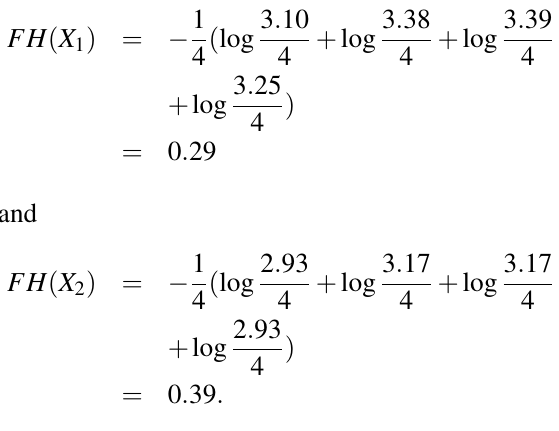
Fig. 1. 1-D Gaussian window